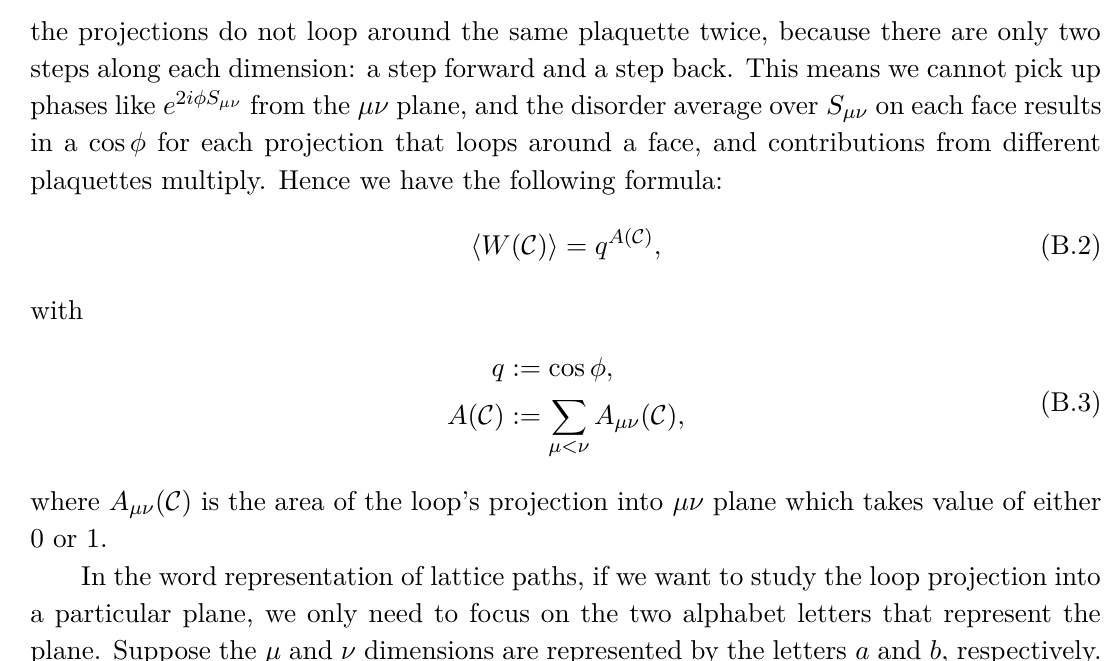
Figure 10 . Three examples of loop paths on hypercube and their representations in terms of words, chord diagrams and intersection